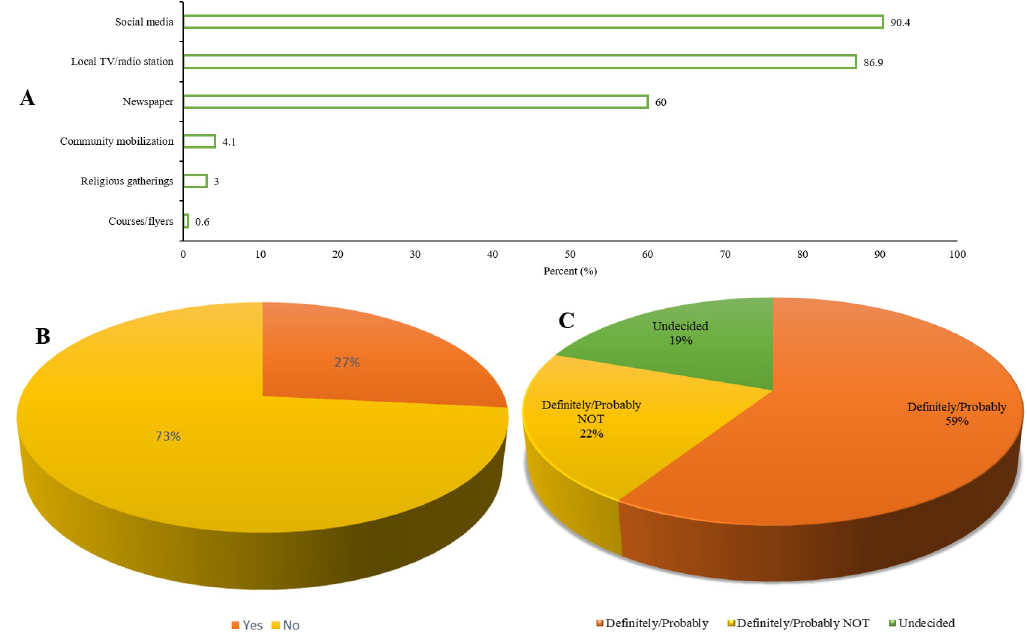
Fig 1. Effectiveness of media campaigns on COVID-19 vaccine. ( A ) vaccine awareness campaign with the most reach. ( B ) COVID-19 test by participants. ( C ) level of COVID-19 vaccine hesitancy among adult Africans.